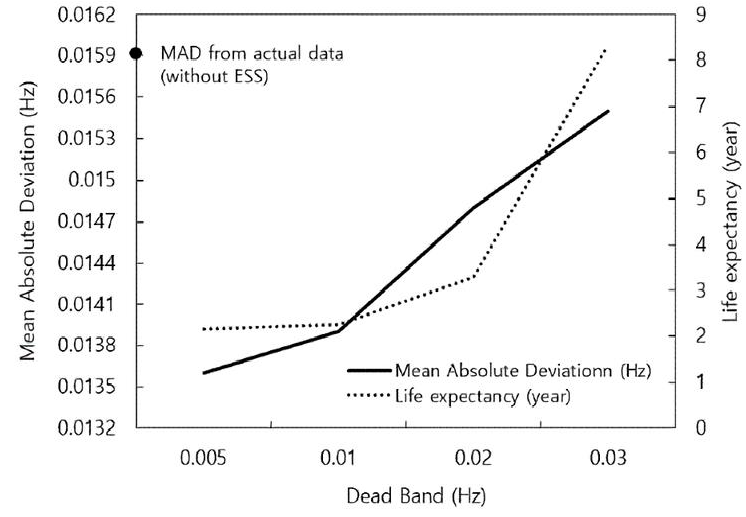
Figure 12. Performance and life evaluation according to dead-band change.